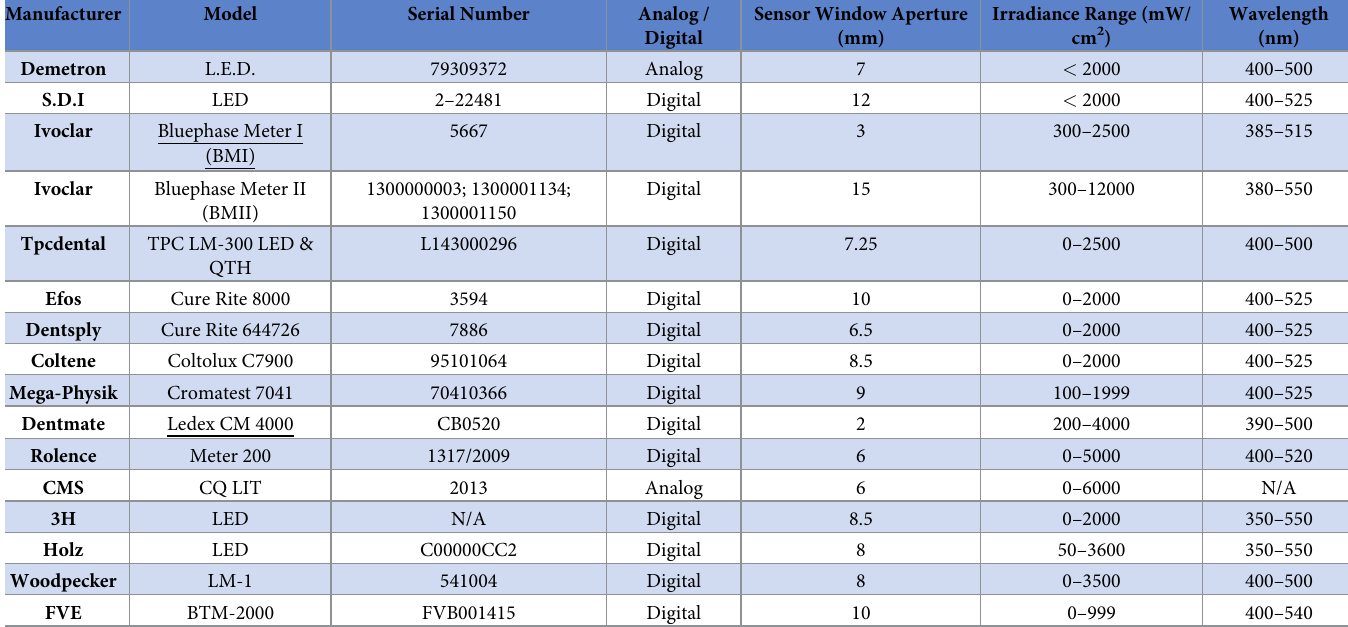
Irradiance and wavelength ranges are drawn from manufacturers’ literature. The two underlined meters BM I and Ledex CM 4000 are the only ones that use linear sensors. Of the tested models, the BM II (n = 3) (Ivoclar-Vivadent, Liechtenstein) is the only radiometer that can measure power. It can also calculate the irradiance if the light probe has a 6 to 12 mm circular